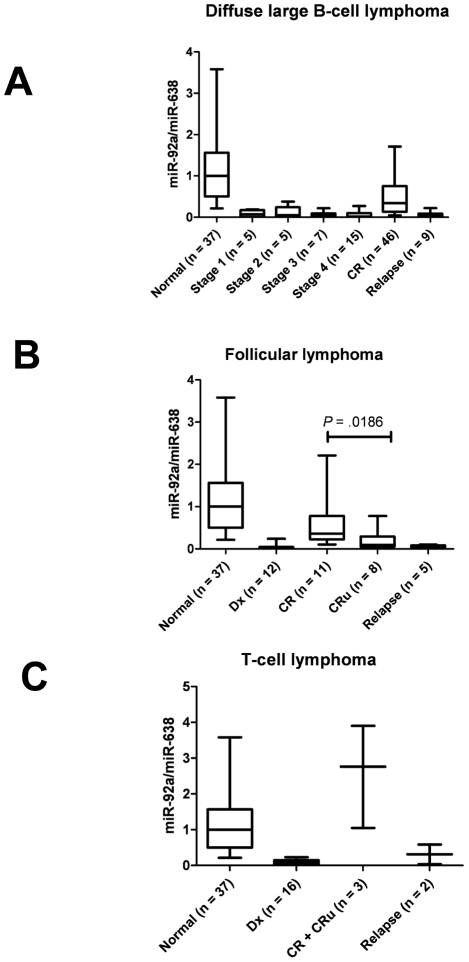
Plasma miR-92a value (miR-92a/miR-638) in patients with non-Hodgkin's lymphoma at various stages.(A) Plasma miR-92a value (miR-92a/miR-638) in patients with diffuse large B-cell lymphoma at the time of diagnosis, in the relapse phase, and in the complete remission (CR) state. Decreased plasma miR-92a values recovered in the CR phase (P<.0001) but were still significantly lower than in normal subjects (P<.0001). Plasma miR-92a levels at relapse decreased again and the levels were similar to those at diagnosis. (B) Plasma miR-92a value (miR-92a/638) in patients with follicular lymphoma at the time of diagnosis (Dx), in the relapse phase, and in the CR or complete remission unconfirmed (CRu) states. Patients with CRu status had significantly lower plasma miR-92a/miR-638 values compared with those who had CR (P = .0186 by the Mann-Whitney test). (C) Plasma miR-92a values (miR-92a/miR-638) in patients with T-cell non-Hodgkin's lymphoma at the time of diagnosis, relapse phase, and complete remission (CR and CRu).